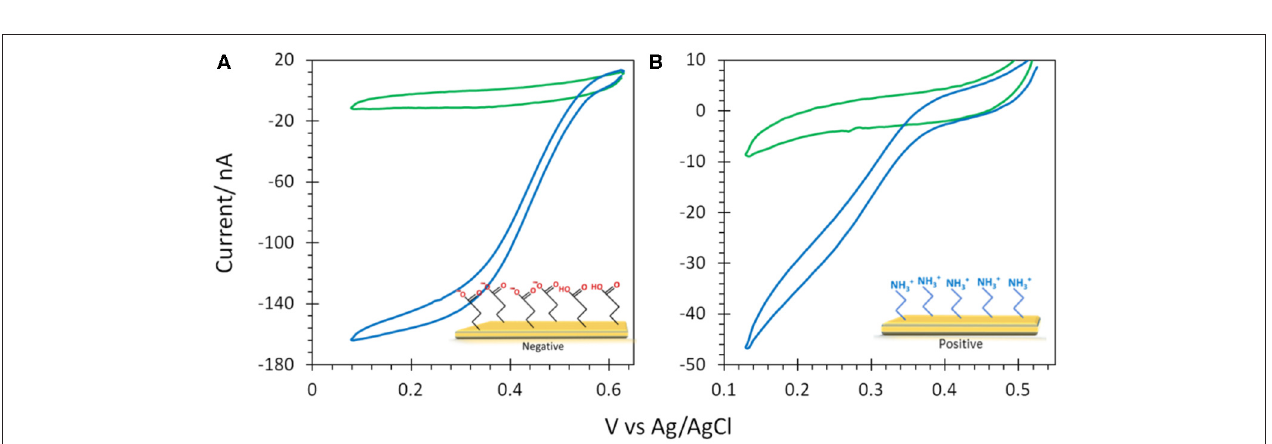
FIGURE 6 | CVs obtained under N 2 (green) and O 2 (blue) after (A) Mv BOD and (B) Tt LAC adsorption on bare ITO electrode; Inset in (A) CV of Mv BOD adsorbed on ITO treated with 6-MHA (black) or CYST (red). Scan rate 10 mV/s. 100mM phosphate buffer pH 6 for Mv BOD and acetate buffer pH 5 for Tt LAC. Enzyme adsorption is made at 4 ◦ C and electrochemistry is carried out at 25 ◦ C.